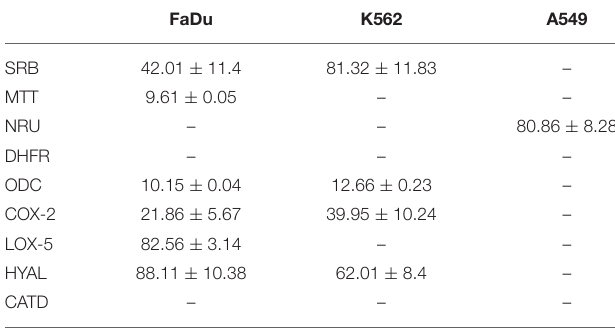
TABLE 2 | IC 50 ( µ M) of carvacrol in cell-based